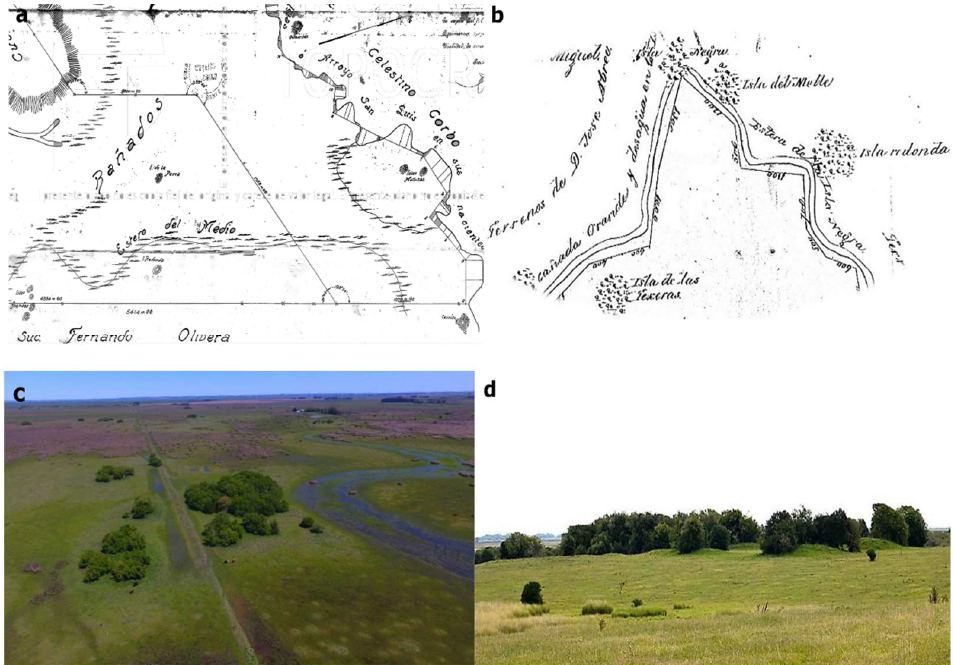
Figure 1. Concept of isla (island) and cerritos (mounds) in cartography and the landscape. ( a ) Section of the measurement plan of the Estero del Medio zone from 1916 (MTOP 106713): Islas Grandes, Isla de la Perra, Isla Redonda, Islas Mellizas, Cinco Islas and Cerrito. ( b ) Section of the measurement plan of the Cañada Grande and San Luis zone from 1831 (MTOP 106428): Isla Negra, Isla Redonda, Isla del Molle, Isla de las Texeras. ( c ) Group of mounds, Los Huesos in the Rincón de la Paja wetland. ( d ) Group of mounds, Los Ajos in the mid-plain close to the Sierra de los Ajos. These assumptions are proposed as the basis of the GIS-based analysis of the present